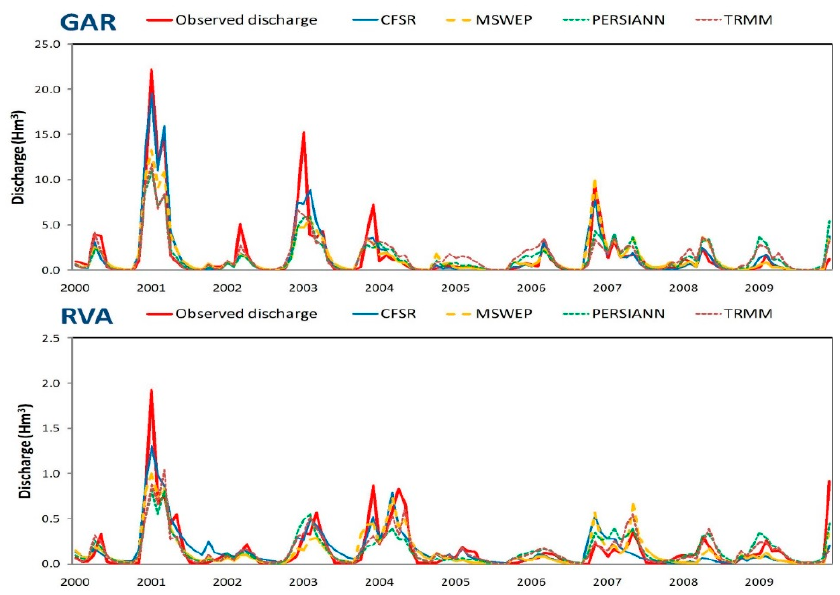
Figure 5. Observed and simulated monthly flow hydrographs for the different datasets using GR2M during the calibration and validation periods (2000–2009).